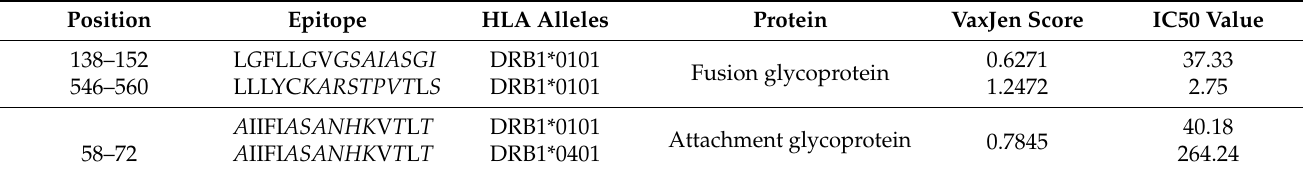
Table 2. Table showing features of the selected HLA II epitopes. In epitope sequence, exposed residues are bold and italicized, while other residues are buried (WESA